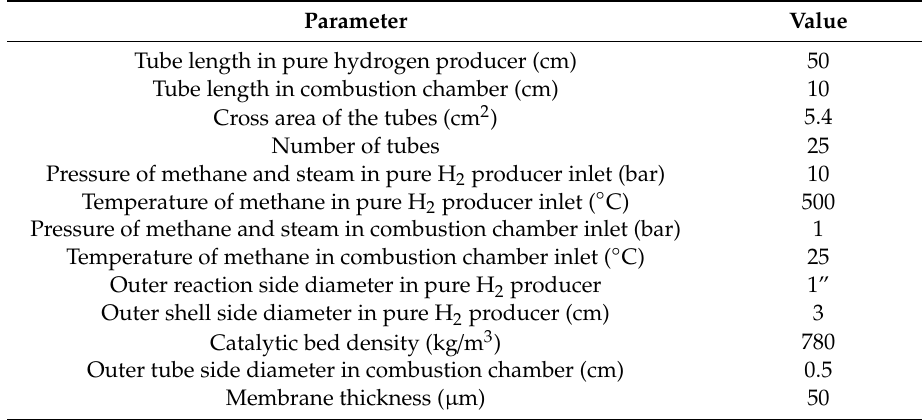
Table 4. The operating and geometric parameters of the on-board processor.